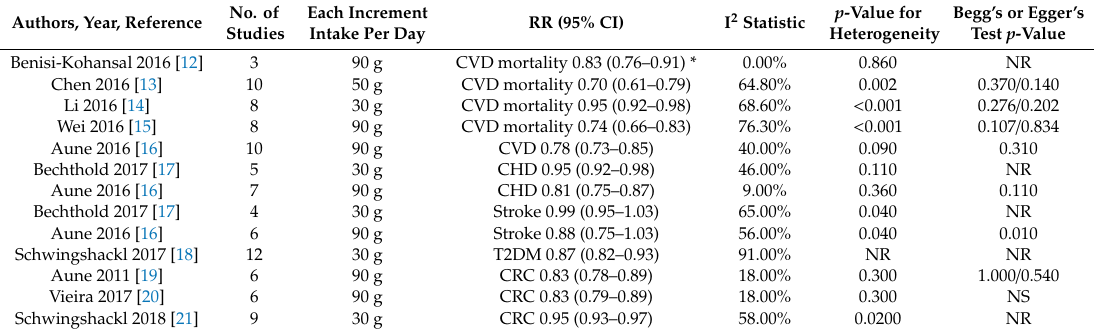
Table 1. Summary of linear dose-response meta-analyses of prospective studies on whole grain intake and CVD, CHD, stroke, T2DM and